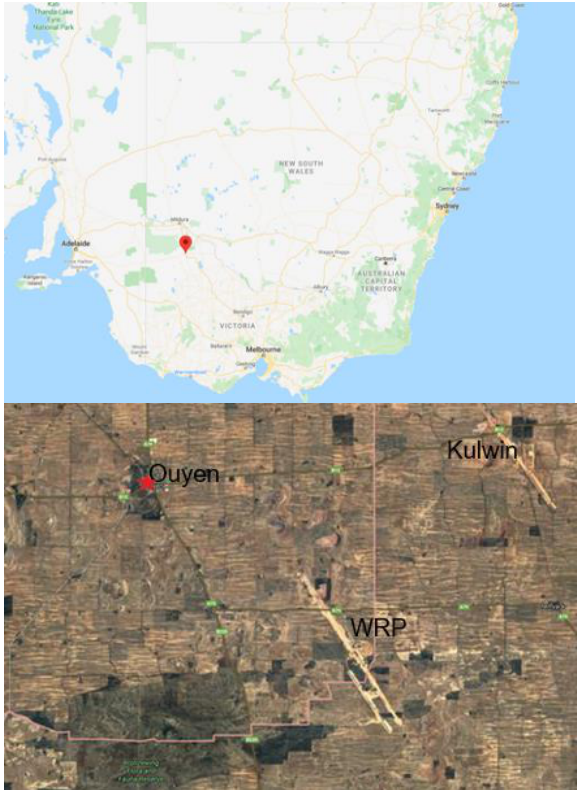
Figure 1: Map displaying the location of the Iluka Resources WRP Mine.